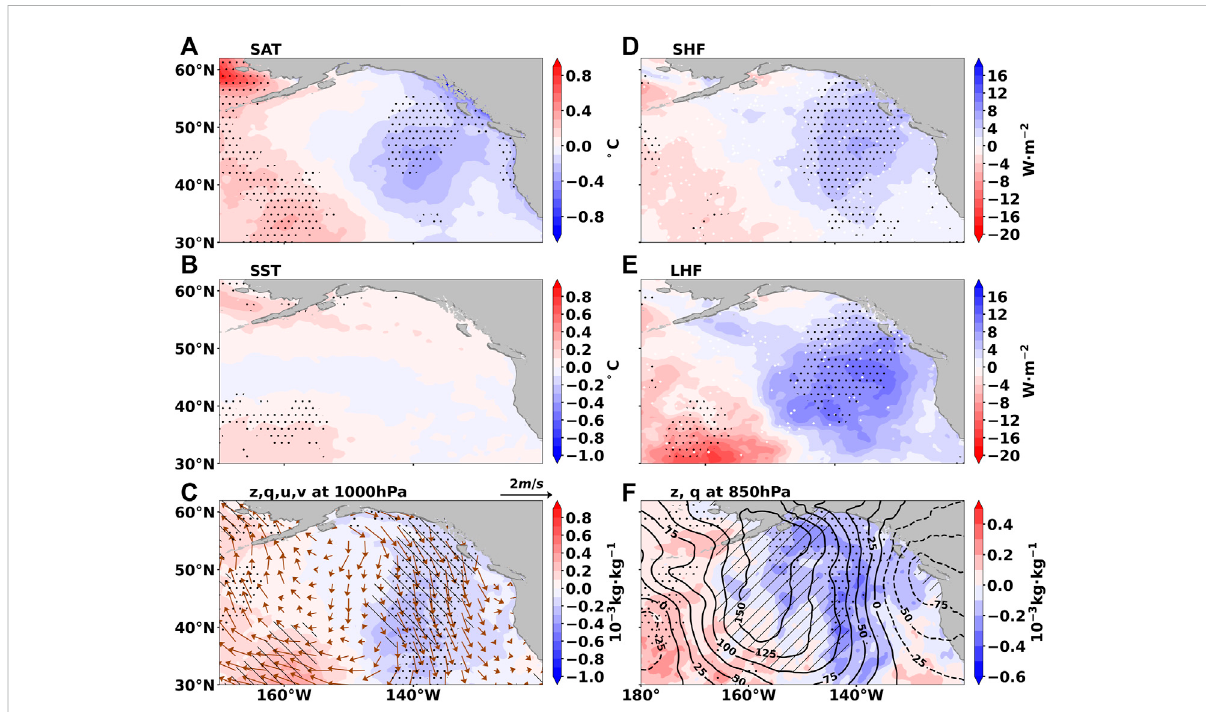
FIGURE 7 Difference between fog with AWSS and that with ACSS. (A) SAT (shaded, ° C), the black dots indicate the SAT difference signi fi cant at the 95% con fi dence level. (B) SST (shaded, ° C), the black dots indicate theSST difference signi fi cant atthe 95% con fi dence level. (C) Horizontal wind (vectors, m · s − 1 ) and speci fi c humidity (shaded, 10 − 3 kg kg − 1 ) at 1000 hPa. The black dots indicate the temperature difference signi fi cant at the 95% con fi dence level. Slash lines indicate the geopotential height anomaly signi fi cant at the 95% con fi dence level. Backslashes indicate the meridional wind signi fi cant at the 95% con fi dence level. (D) SHF (shaded, W · m − 2 ), and the black dots indicate the SHF difference signi fi cant at the 95% con fi dence level. (E) LHF (shaded, W · m − 2 ); the black dots indicate the LHF difference signi fi cant at the 95% con fi dence level. (F) Geopotential height (black contour, gpm) and speci fi c humidity (shaded, 10 − 3 kg kg − 1 ) at 850 hPa. The black dots indicate the speci fi c humidity difference signi fi cant at the 95% con fi dence level. The slash lines indicate the geopotential height anomaly signi fi cant at the 95% con fi dence level.